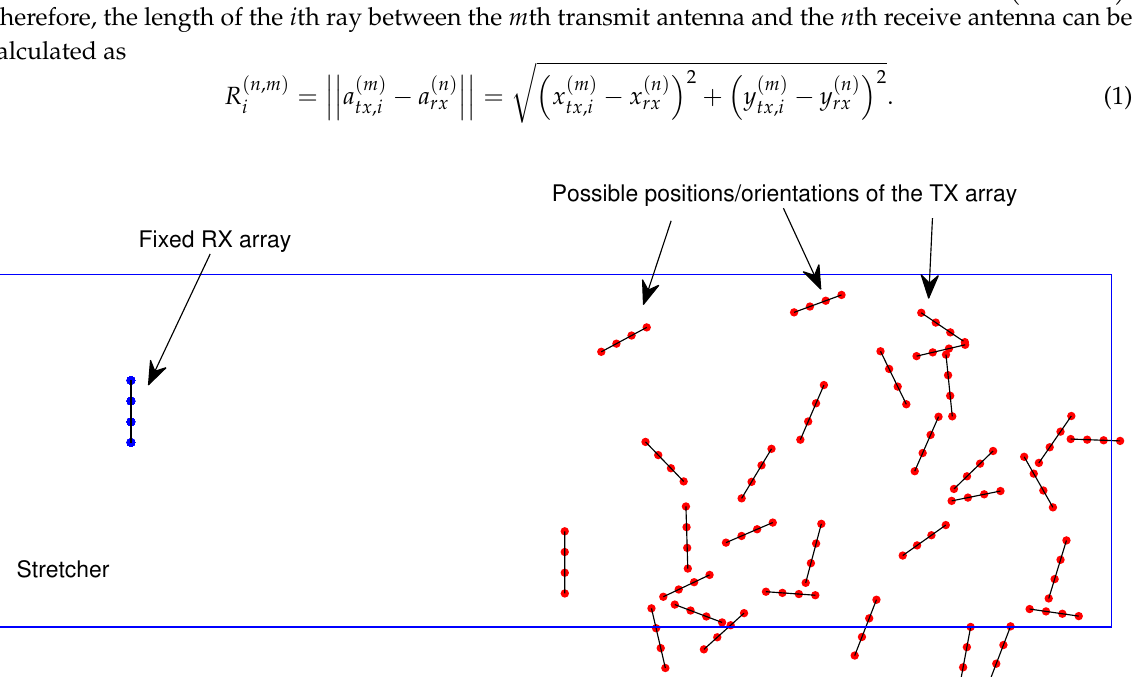
Figure 3. Different CathLab scenarios considering a 4 × 4 MIMO system and different values of d MN